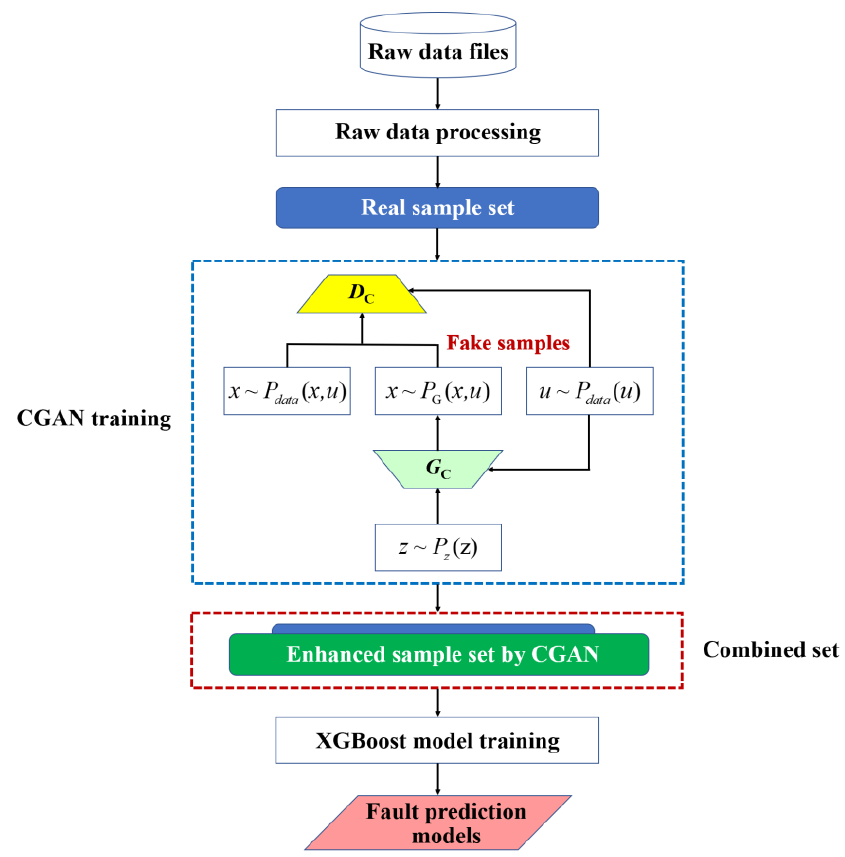
Figure 4. Work low of the CGAN augmentation process.